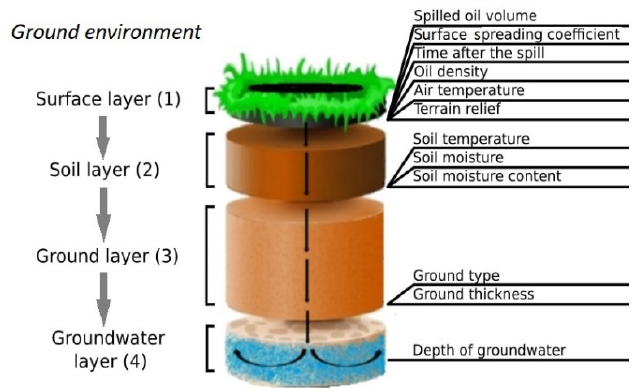
Figure 2. The visualization of the mathematical model for predicting the impact of an oil spill on the ground environment.